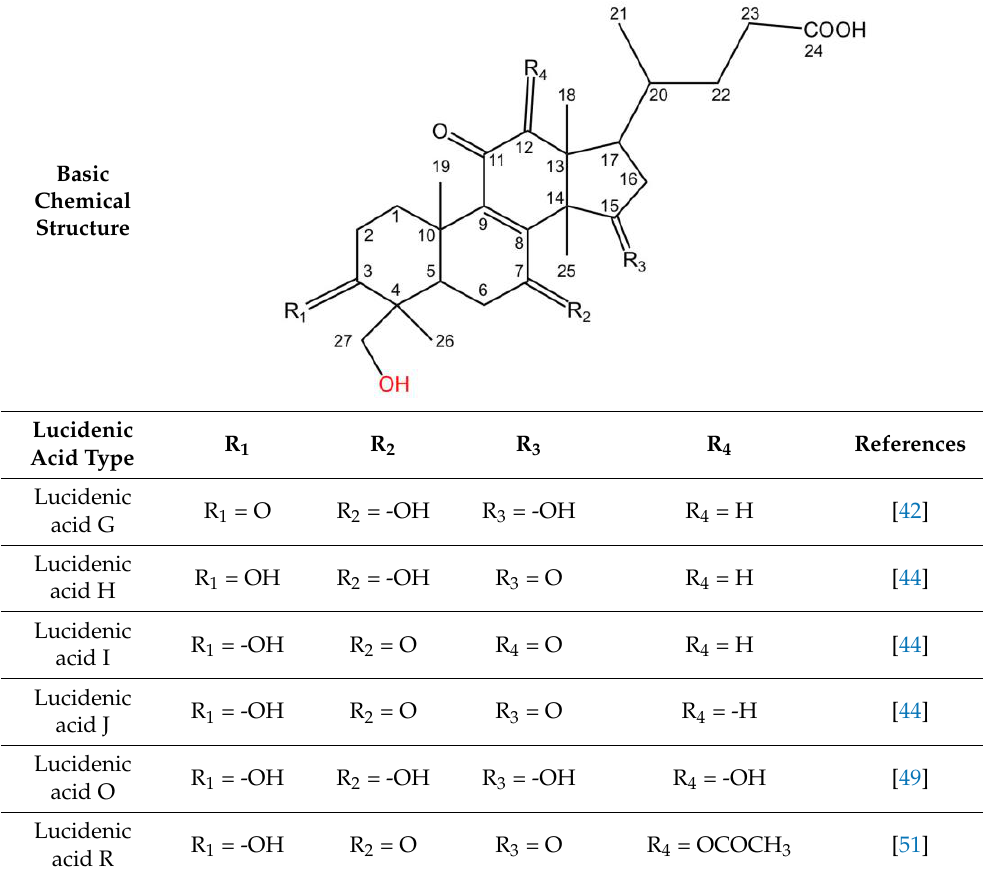
Table 4. Potential pharmacological effects of lucidenic acids and derivatives.